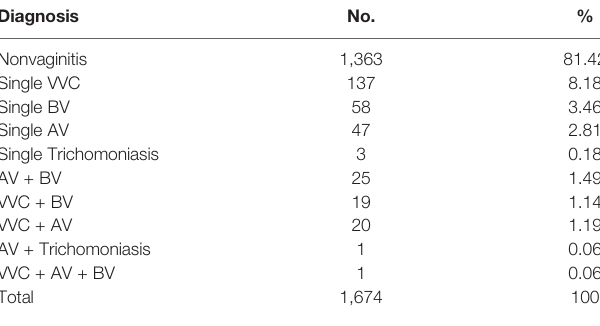
TABLE 1 | Prevalence of single and mixed vaginitis in pregnant